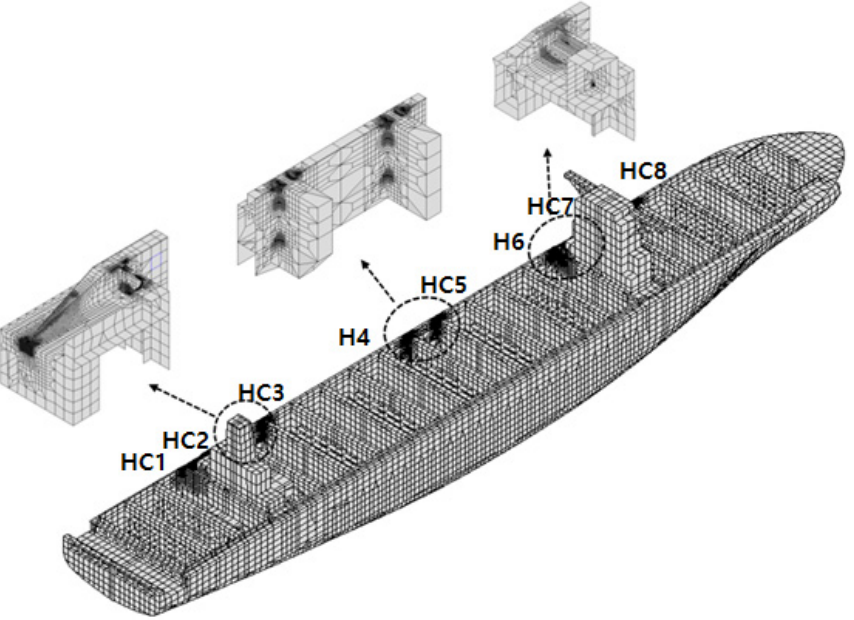
Figure 13. Hot spot points for fatigue analysis.